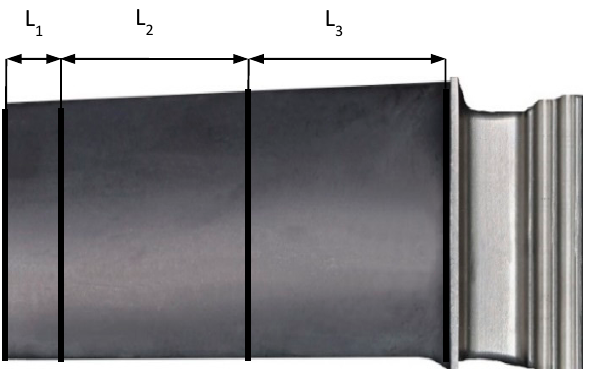
Figure 3. General pattern of gas turbine blade division into samples (Reprinted with permission from Ref. [8]. 2022, AFIT.).